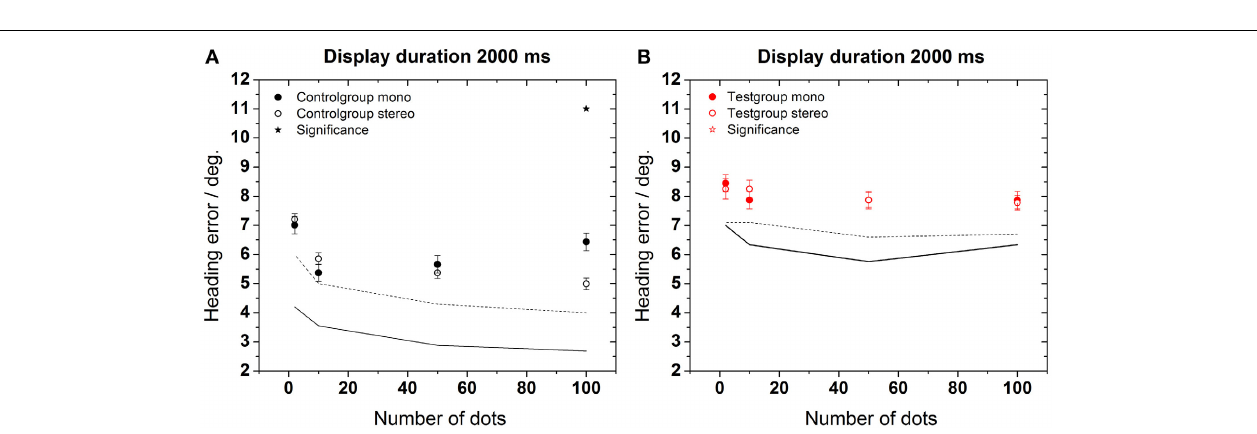
group for only the largest number of dots in the display as indicated by the asterisk. The dashed lines in each panel represent the results from Experiment 1 as shown in Figure 4 (coherent motion, non-stereoscopic stimulation). The solid lines in each panel represent the results from Experiment 2 as shown in Figure 6 (coherent motion, stereoscopic